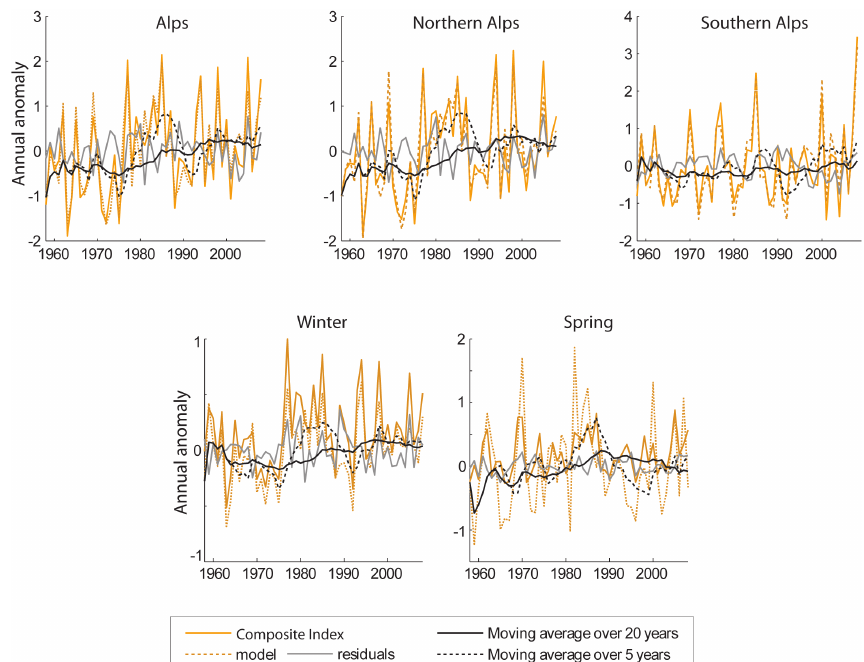
Fig. 4. Composite index (orange solid line) versus regression model (orange dashed line) and model residuals (dashed grey line) for the whole French Alps, the Northern and Southern subregions, and over winter and spring subperiods. Moving averages over 20 and 5yr for the regression models are represented in black solid and dashed lines,